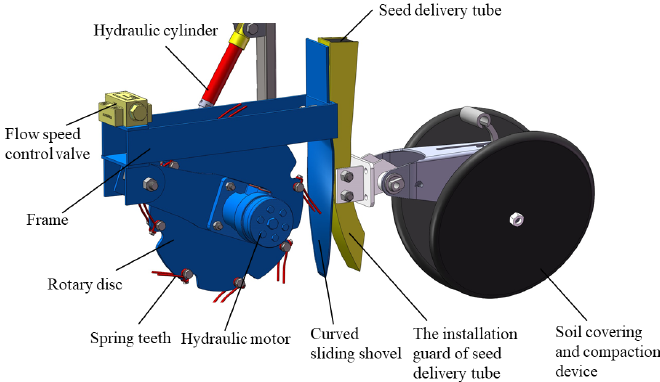
Figure 3. Structural diagram of seed furrow clearing device.